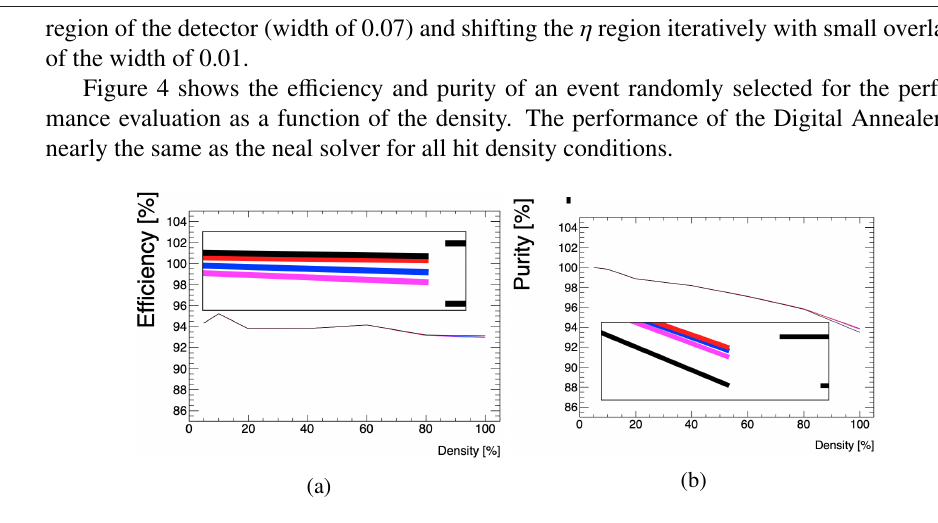
Figure 4: E ffi ciency (a) and purity (b) as a function of a fraction of a hit density for a HL- LHC pileup environment. Black line is a result by the neal solver. Magenta, blue and red line show results by the Digital Annealer with di ff erent solver-configurations.